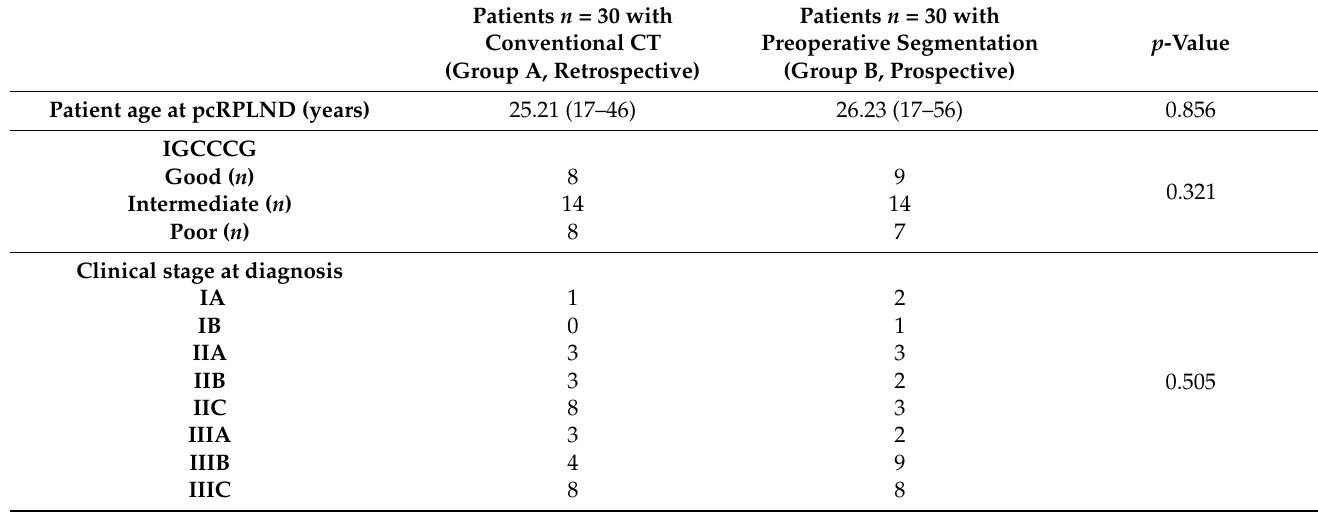
Table 1. Clinical information of retrospective and prospective